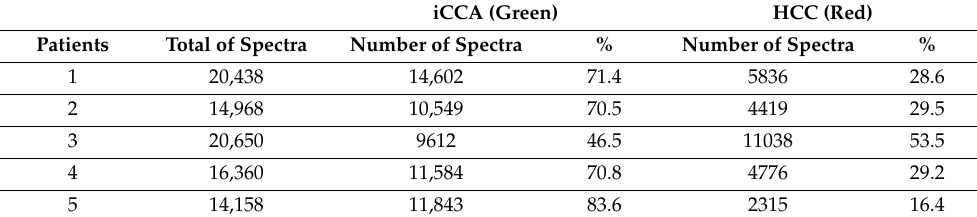
Table 2. Quantification of hepatocyte and cholangiocyte components using MALDI-MSI segmentation.